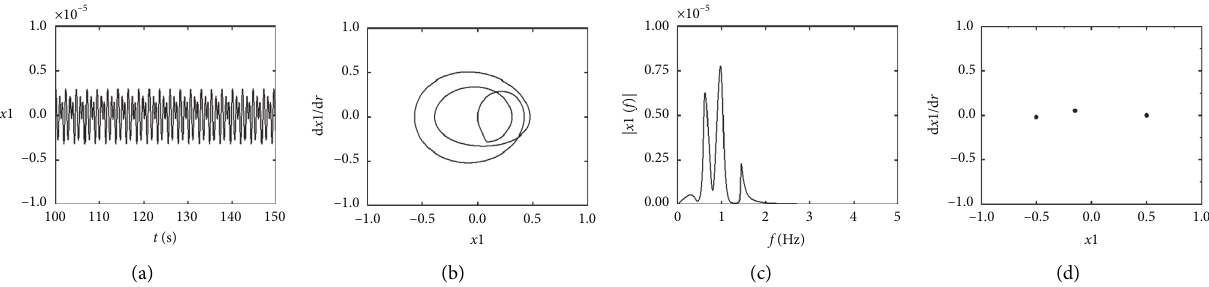
Figure 14: Numerical analysis results at ω � 2061rad/s, k and (d) Poincare map.